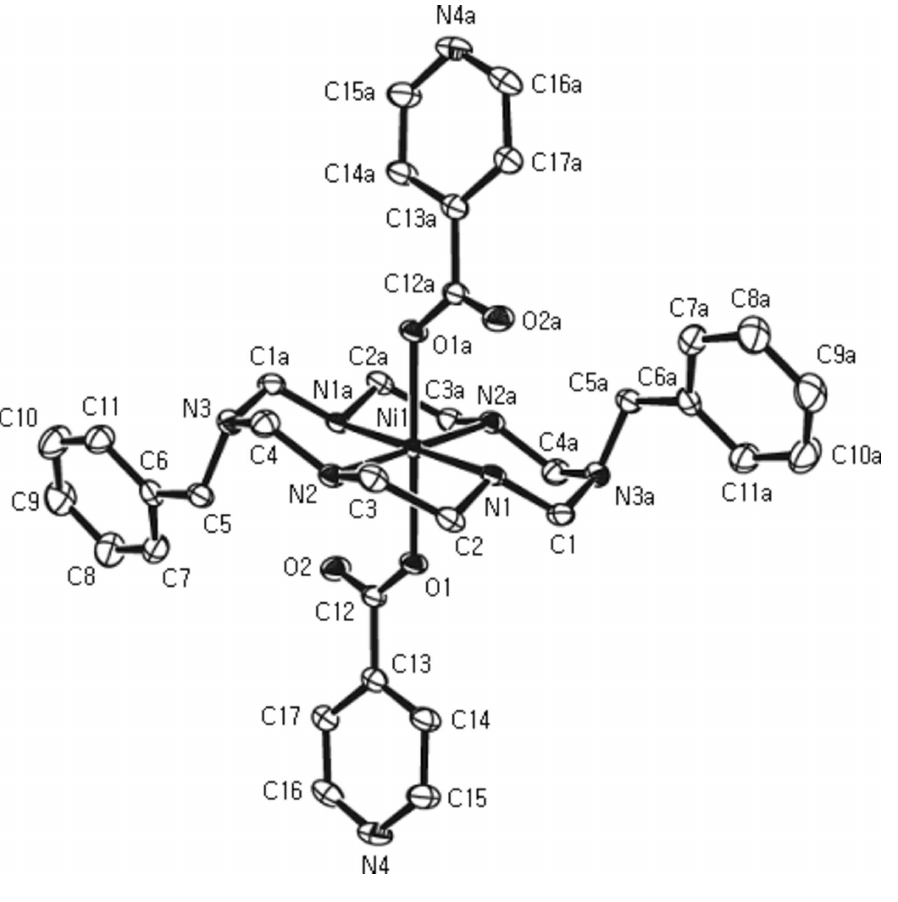
View of the molecular structure of the title compound showing 50% displacement ellipsoids for the non-hydrogen atoms. Atoms labeled with the suffix a are at the symmetry position (1 - x , 1 - y , 2 - z